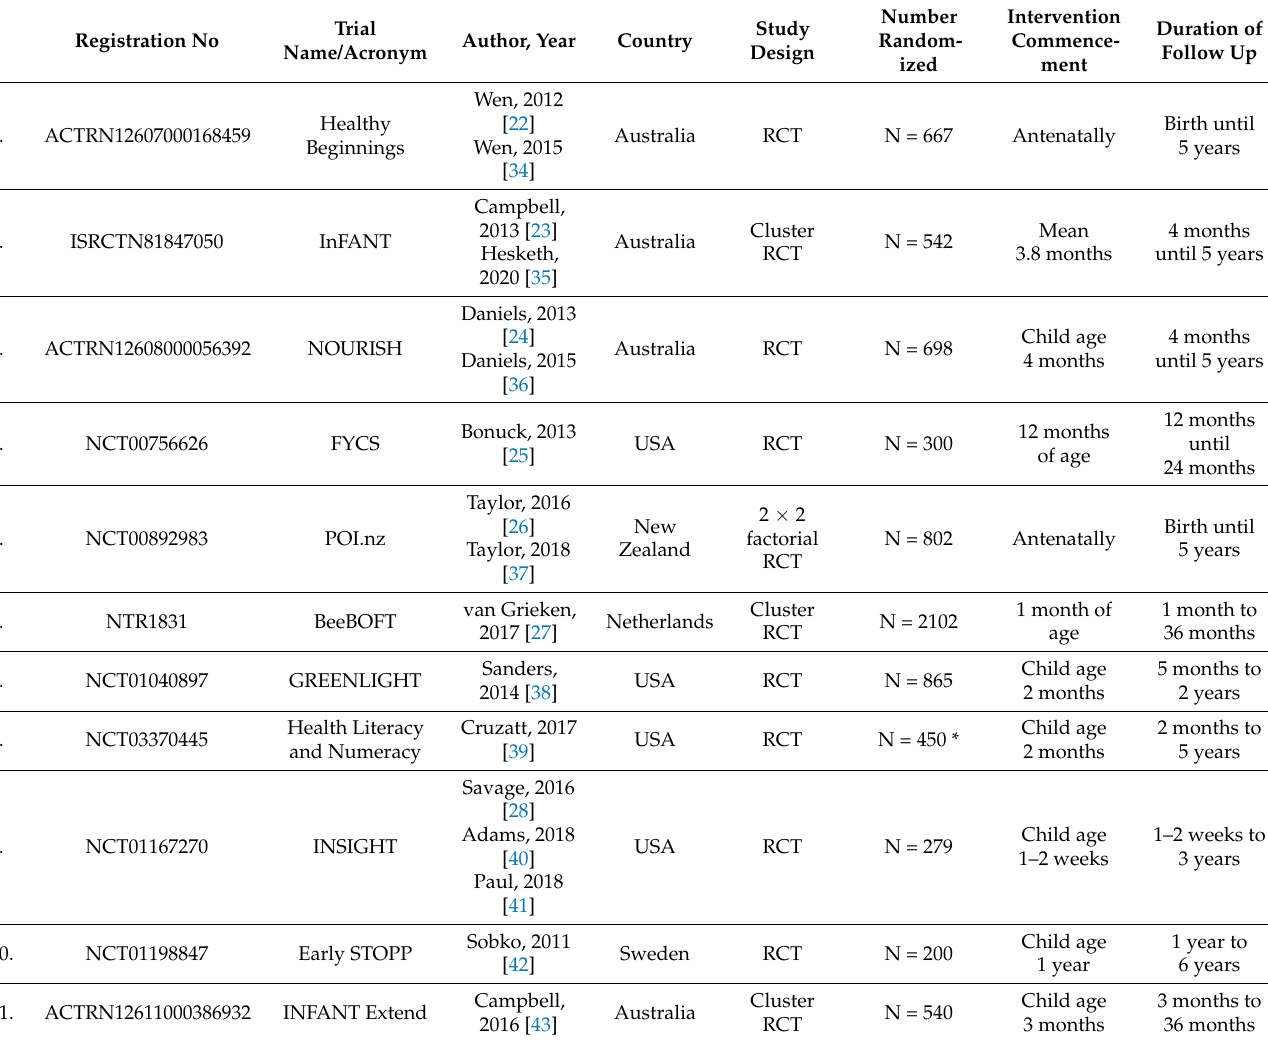
Table 1. Characteristics of early intervention studies for the prevention of obesity in infancy (n =